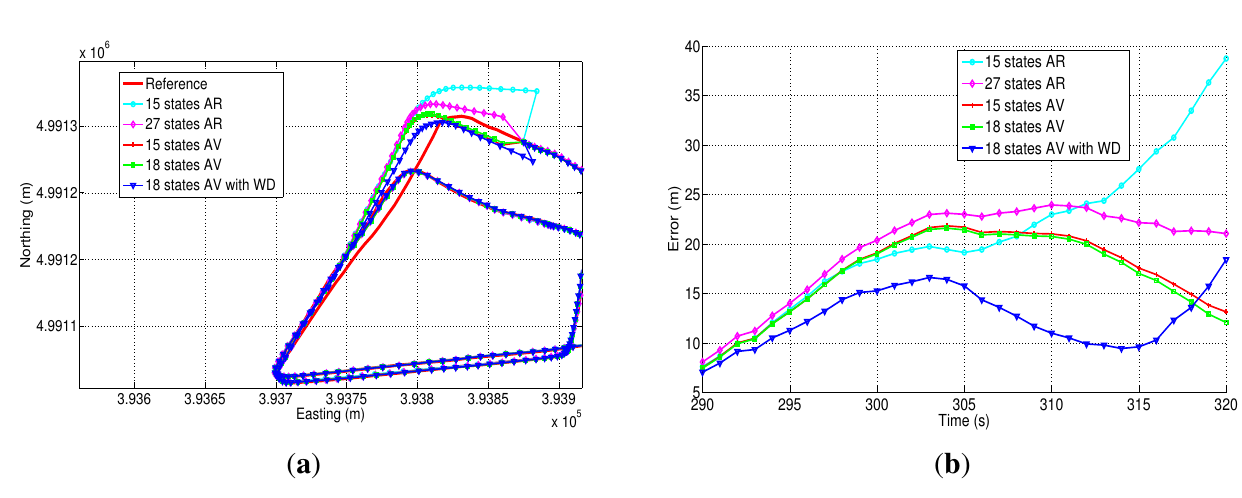
Figure 21. ( a ) Horizontal position during GPS outage 1; ( b ) horizontal position error during GPS outage 1.